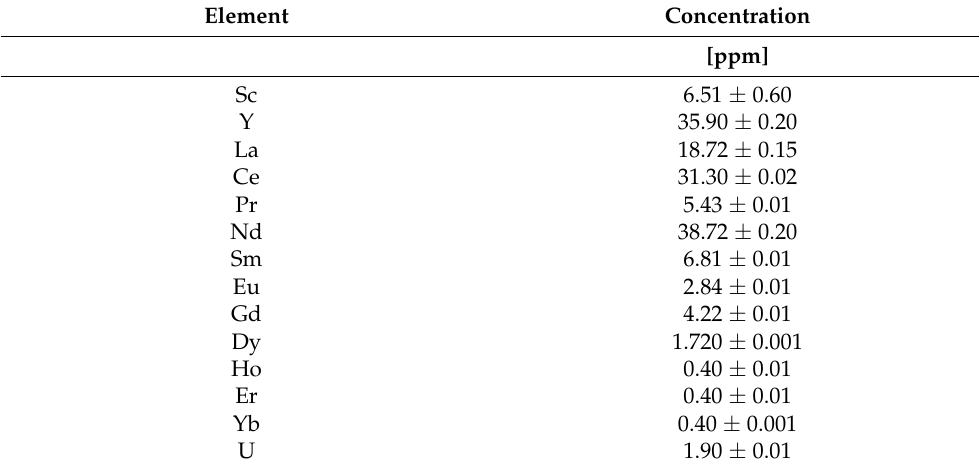
Table 18. Concentrations of REEs in the (M + NM) phase of the solid residue.